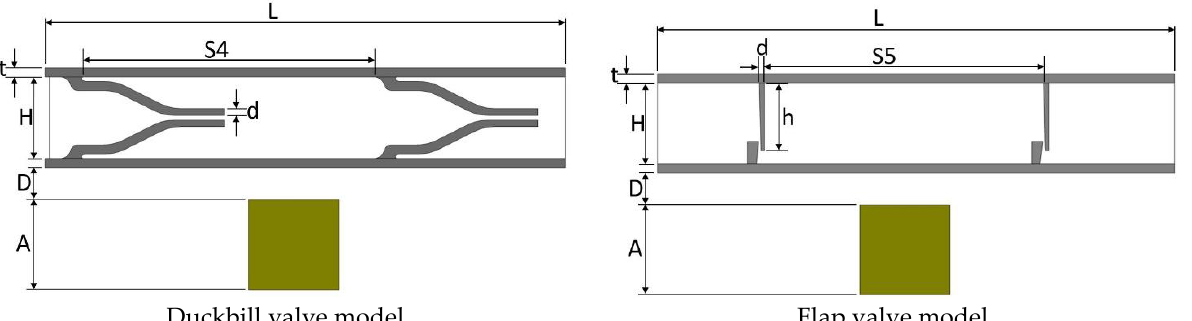
Table 2. Properties of microchannels.